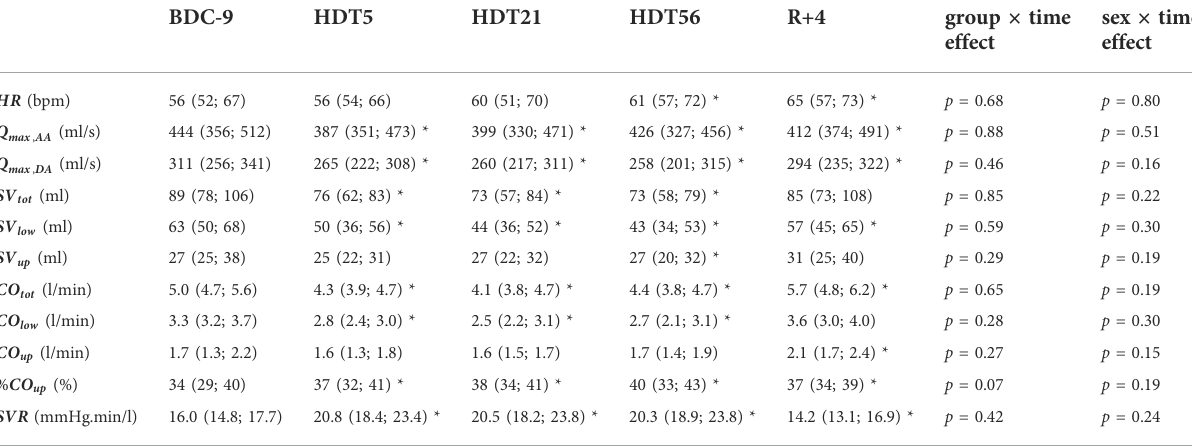
TABLE 2 Evolution of blood fl owresultsin the ascending and the descending aorta (AA and DA,respectively) all over the study. Data are presented as median ( fi rst quartile; third quartile). The group × time and sex × time effects are displayed in the last columns. HR : heart rate, Q max : maximum blood fl owrate, SV tot :totalstroke volume, SV low :stroke volume allocated tothe lowerbody, SV up :stroke volume allocatedto the upper body. Their equivalent in terms of cardiac output is noted CO tot , CO low , and CO up , respectively. % CO up : percentage of cardiac output allocated to the upper body. SVR : systemic vascular resistance. BDC: baseline data collection, HDT: head-down tilt, R: recovery. *: Signi fi cant difference with BDC-9 using the two-stage linear step-up procedure of Benjamini, Krieger, and Yekuteli with a false discovery rate set at 0.05.